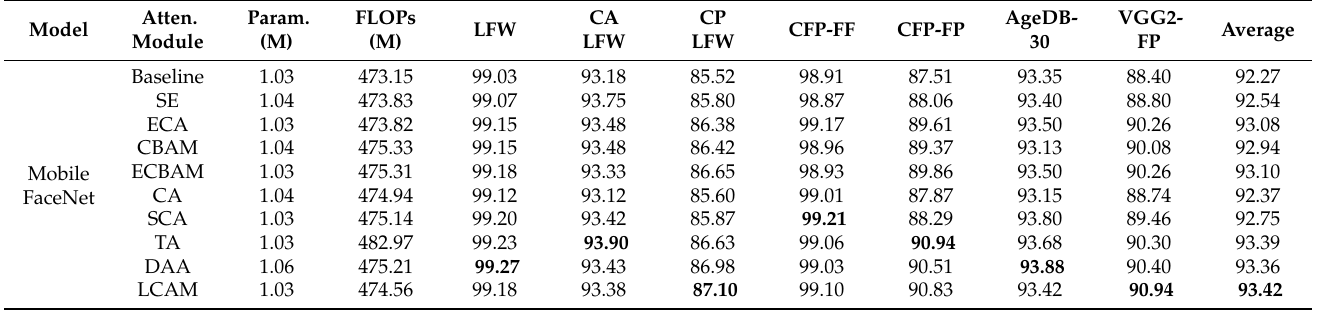
Table 9. Performance results of different attention modules plug into MobileFaceNet. These results are reported in terms of parameters, FLOPs and verification accuracy for LFW, CALFW, CPLFW, CFP-FF, CFP-FP, AgeDB-30 and VGG2-FP. Moreover, the average accuracy for the seven image-based datasets is shown in the last column. (Bold values are the highest obtained values by the methods).